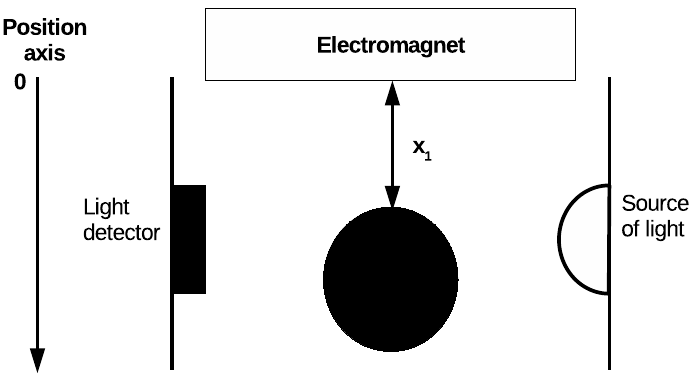
Figure 5. Diagram of measuring the distance between the ball and the electromagnet, with marked distance orientation and a distance measuring